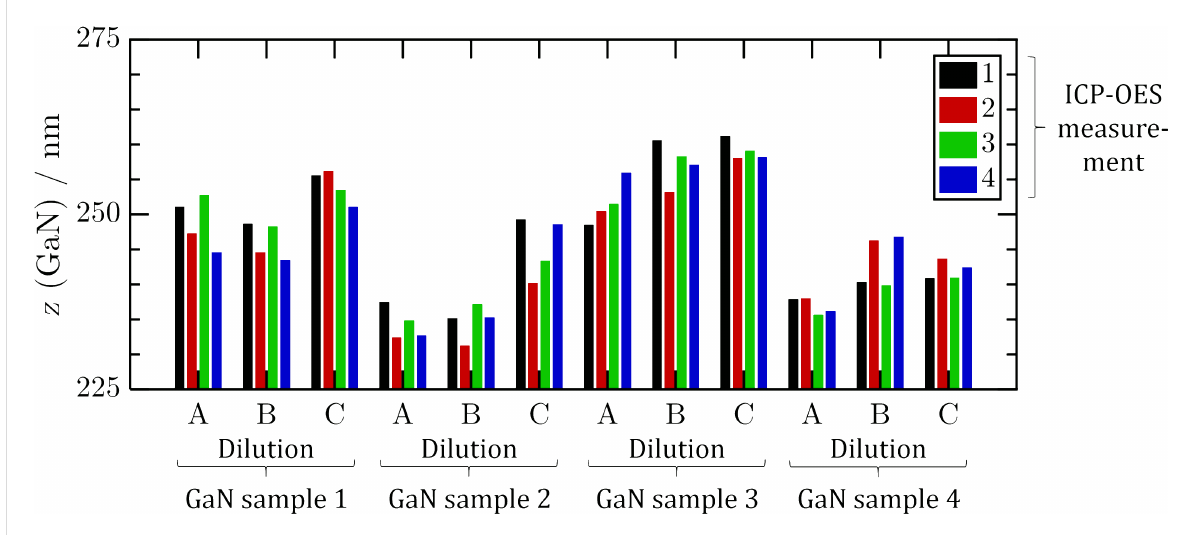
Figure 2: Reproducibility analysis of the ICP-OES method for determining etch depth z (GaN). Four GaN samples 1–4 were etched under identical conditions, i.e., in 30 wt % KOH at RT for 1 h. Each KOH etching solution was diluted three times to yield three sample solutions A, B and C. Each of the combined 12 sample solutions was measured four times.